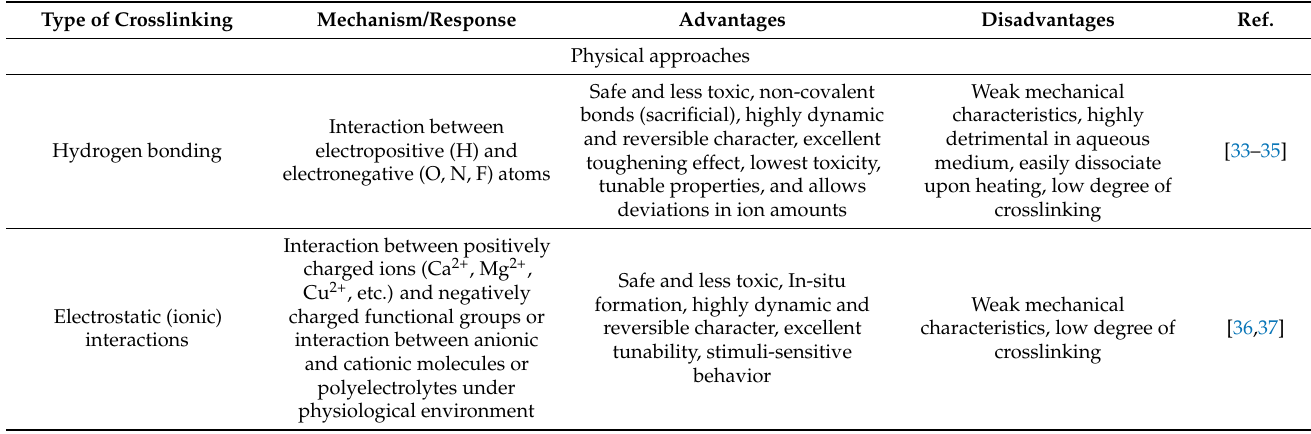
Figure 2. Various potential crosslinking approaches utilized for manufacturing hybrid hydrogels. Table 1. Potential physical and chemical crosslinking approaches for creating hybrid hydrogels.